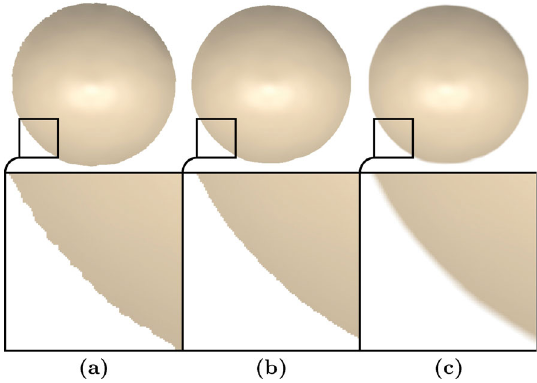
Fig. 7 Edge rendering methods. (a) The mesh is rendered; (b) mesh triangles are cut off at a user-defined confidence value; and (c) mesh triangles smoothly transition from opaque to transparent based on confidence